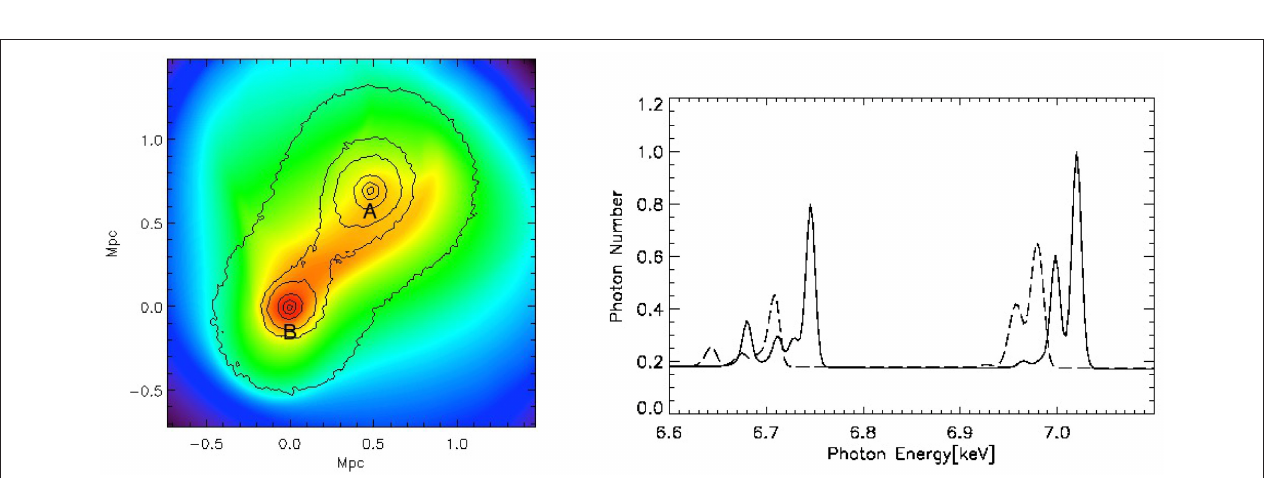
FIGURE 5 | Left panel: X-ray surface brightness image based on an N-body/hydrodynamical simulation ( FLASH ) for the merging cluster El Gordo (from Molnar and Broadhurst, 2015 ). Black contours represent the dark matter distribution. The dark matter centers of the main and the infalling cluster are marked with A and B. Right panel: Simulated spectra around the Fe K line complex extracted from our FLASH simulation (shown in the left panel) around A and B ; dashed and solid lines). The frequency shift due to the relative LOS velocity (1900 kms − 1 ) between A and B can be seen clearly.